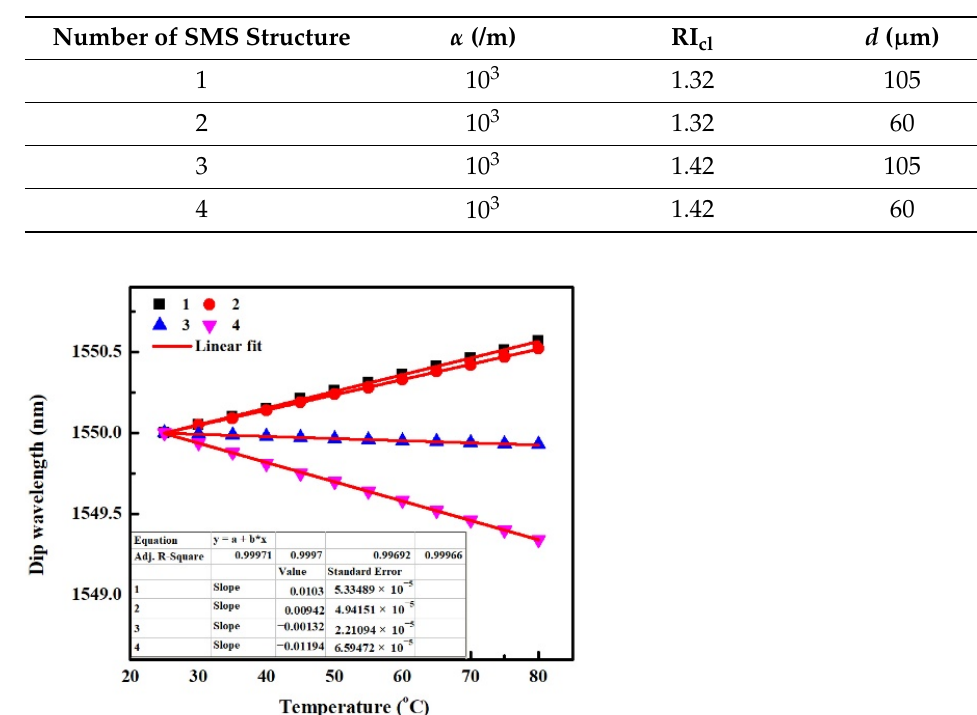
Figure 6. Dip wavelength as a function of the temperature for SMS fiber structures, only the TOE cl is taken into account in the simulation. Table 2. Parameters of MMF in the SMS fiber structure.